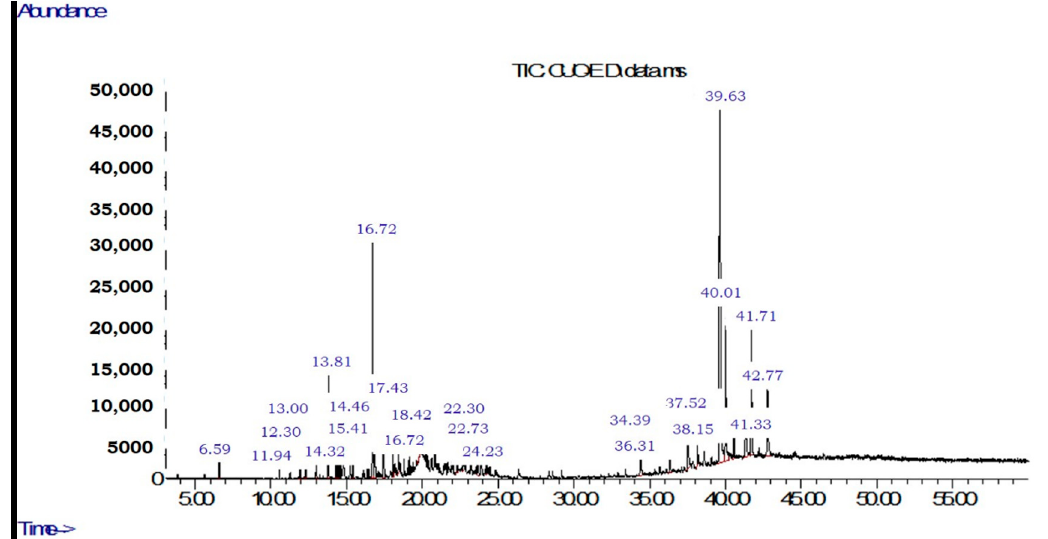
Figure A7. Dipteryx odorata endocarps extract chromatogram.